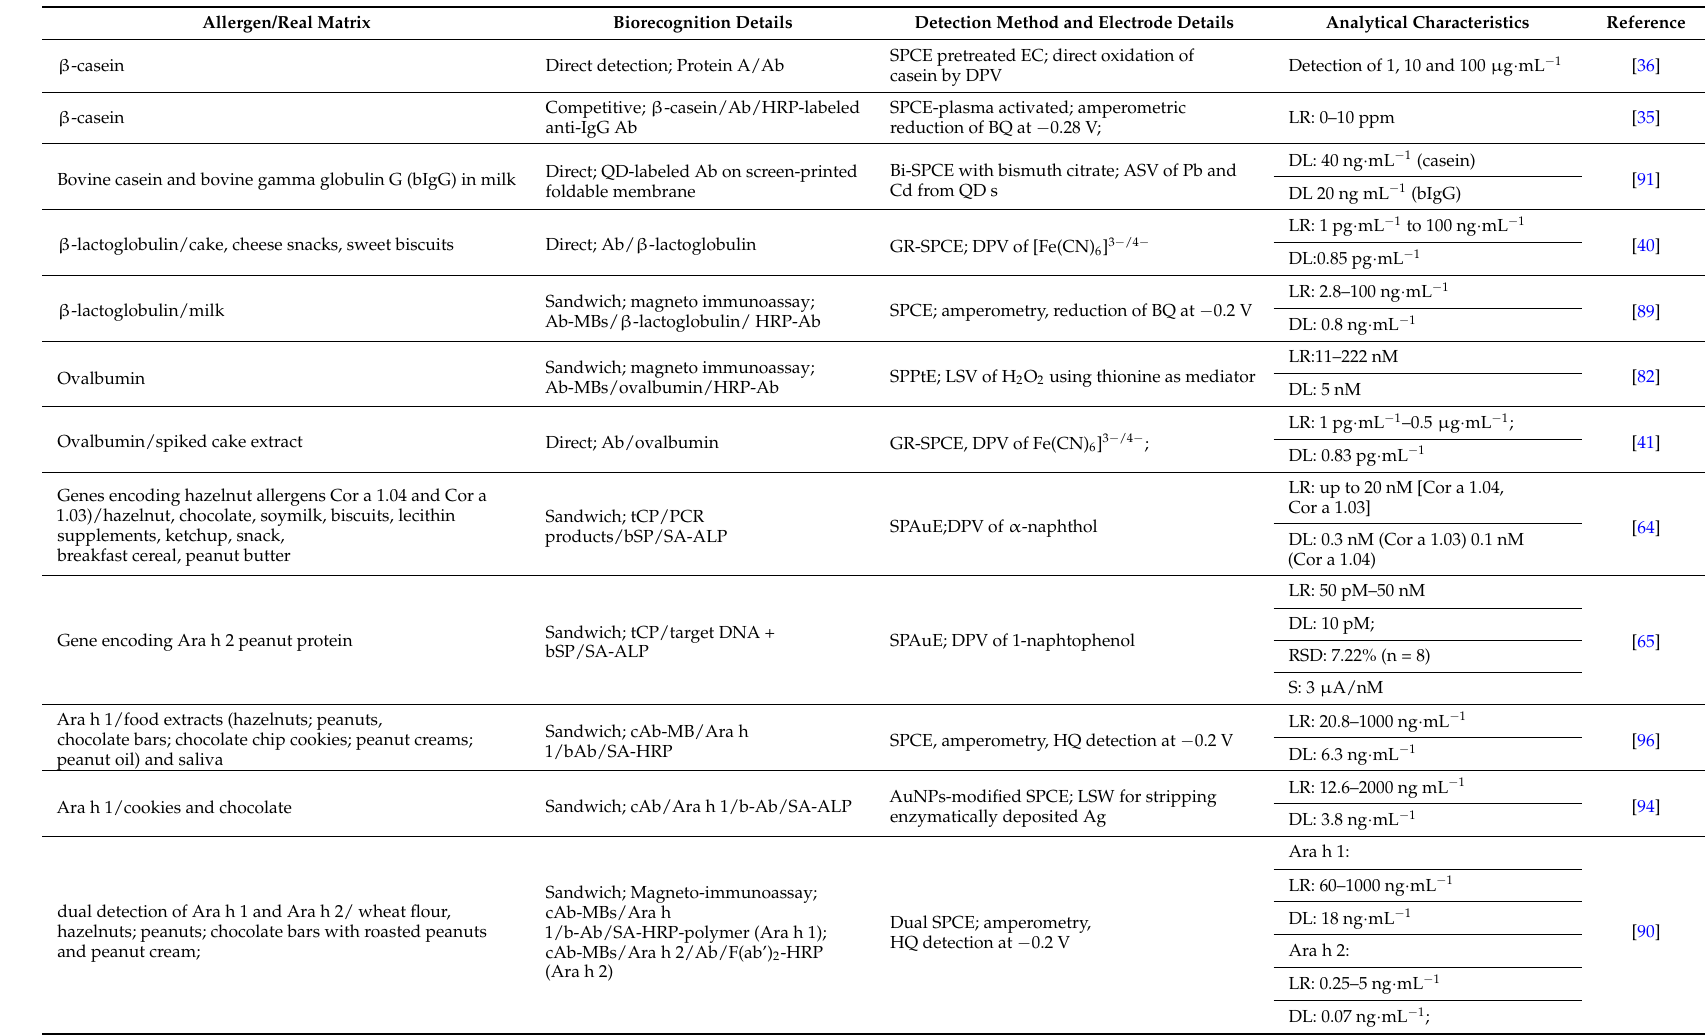
Table 1. Examples of biosensors for the detection of allergens based on screen-printed